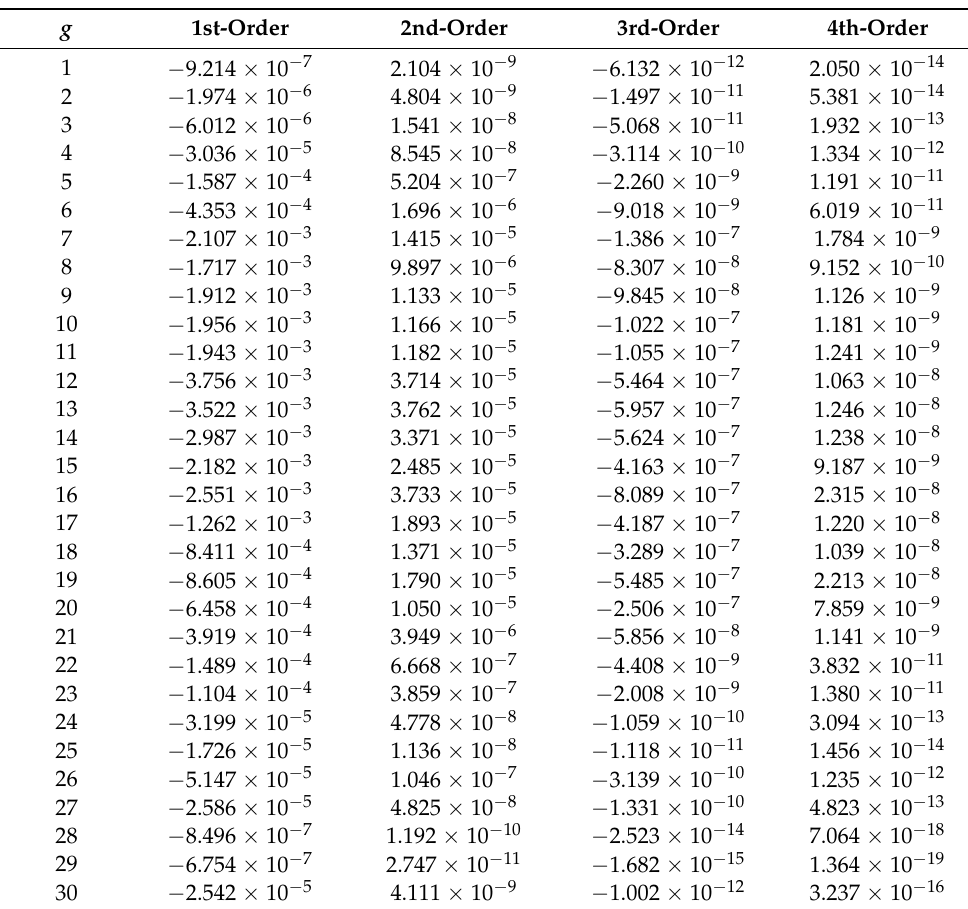
Table 4. Comparison of the 1st-order, 2nd-order, 3rd-order, and 4th-order unmixed relative sensitiv- ities, S ( 1 ) 3 ( 69 Ga).